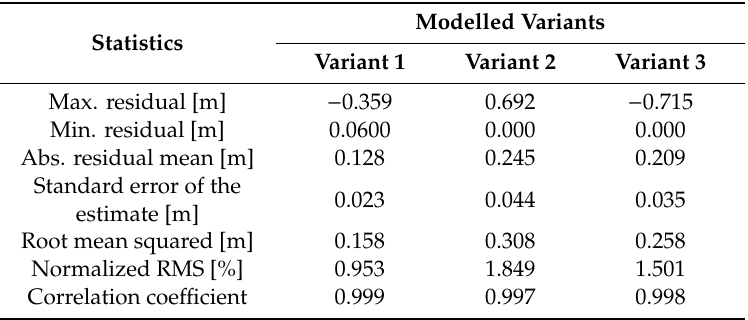
Table 2. Statistics and errors of the modelled variants.